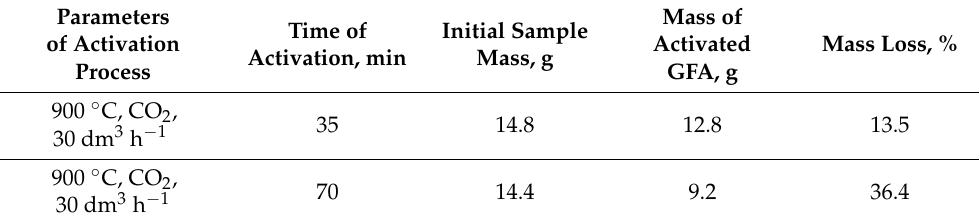
Table 10. Parameters of activation process with CO 2 in laboratory vertical oven at 900 ◦ C. The heating rate to activation temperature was 10 ◦ C min − 1 . The time of stabilization before the activation process was 1 h (in a nitrogen stream of 30 dm 3 h − 1 ). Mass of Parameters Time of Initial Sample Activated Mass Loss, % of Activation Activation, min Mass, g GFA, g Process 900 ◦ C, CO 2